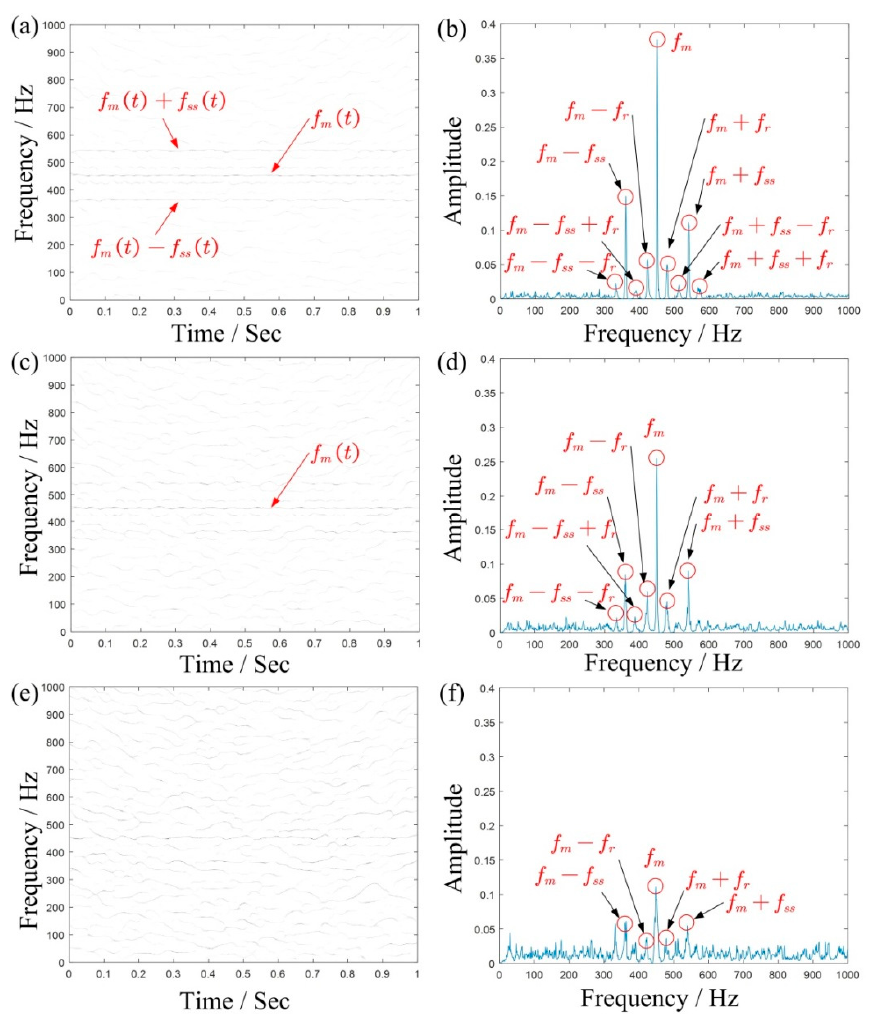
Figure 10. The result analysis of simulated signals under different noise levels: ( a ), ( c ), and ( e ) are TFRs using IMSST, respectively; ( b ), ( d ), and ( f ) are the 2D energy-frequency maps, respectively.